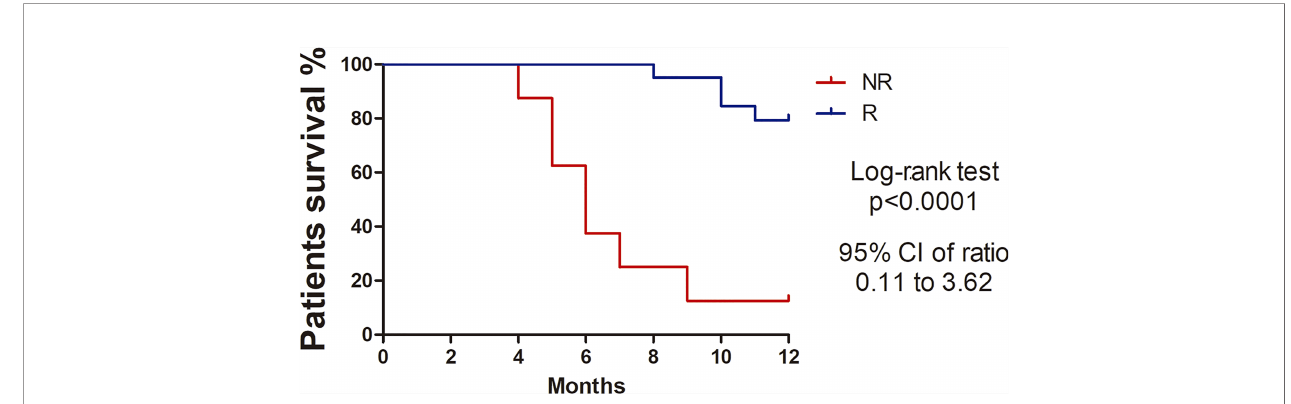
FIGURE 1 | Kaplan-Meier survival curves showing higher percentage survival in Responder patients with cervical cancer. Log-rank test (Chi square 22.34, p<0.0001). Hazard ratio 0.64 (95%, CI